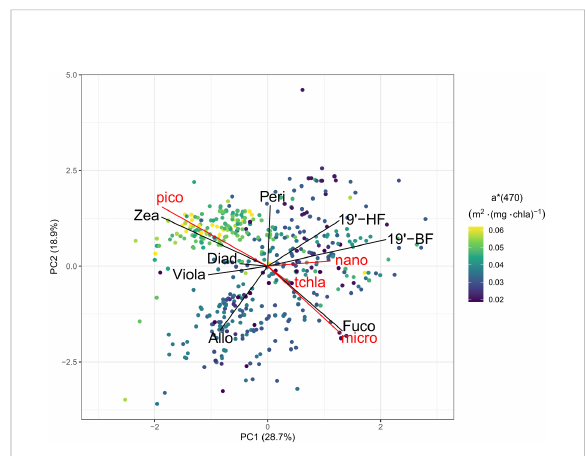
FIGURE 5 Orthogonal projection of the two fi rst principal components of the PCA analysis of the concentrations of the seven diagnostic pigments in Northwestern Mediterranean Med-Bouss dataset, between 5 and 60 m depth over 3 years (2013 – 2015). The color of each point represents the Chla-speci fi c absorption coef fi cient at 470 nm, a*(470), which did not serve in the construction of the projection. The relative contribution to Chla of each of the three phytoplankton size classes and the seasons are superimposed as supplementary variables onto the PCA projection